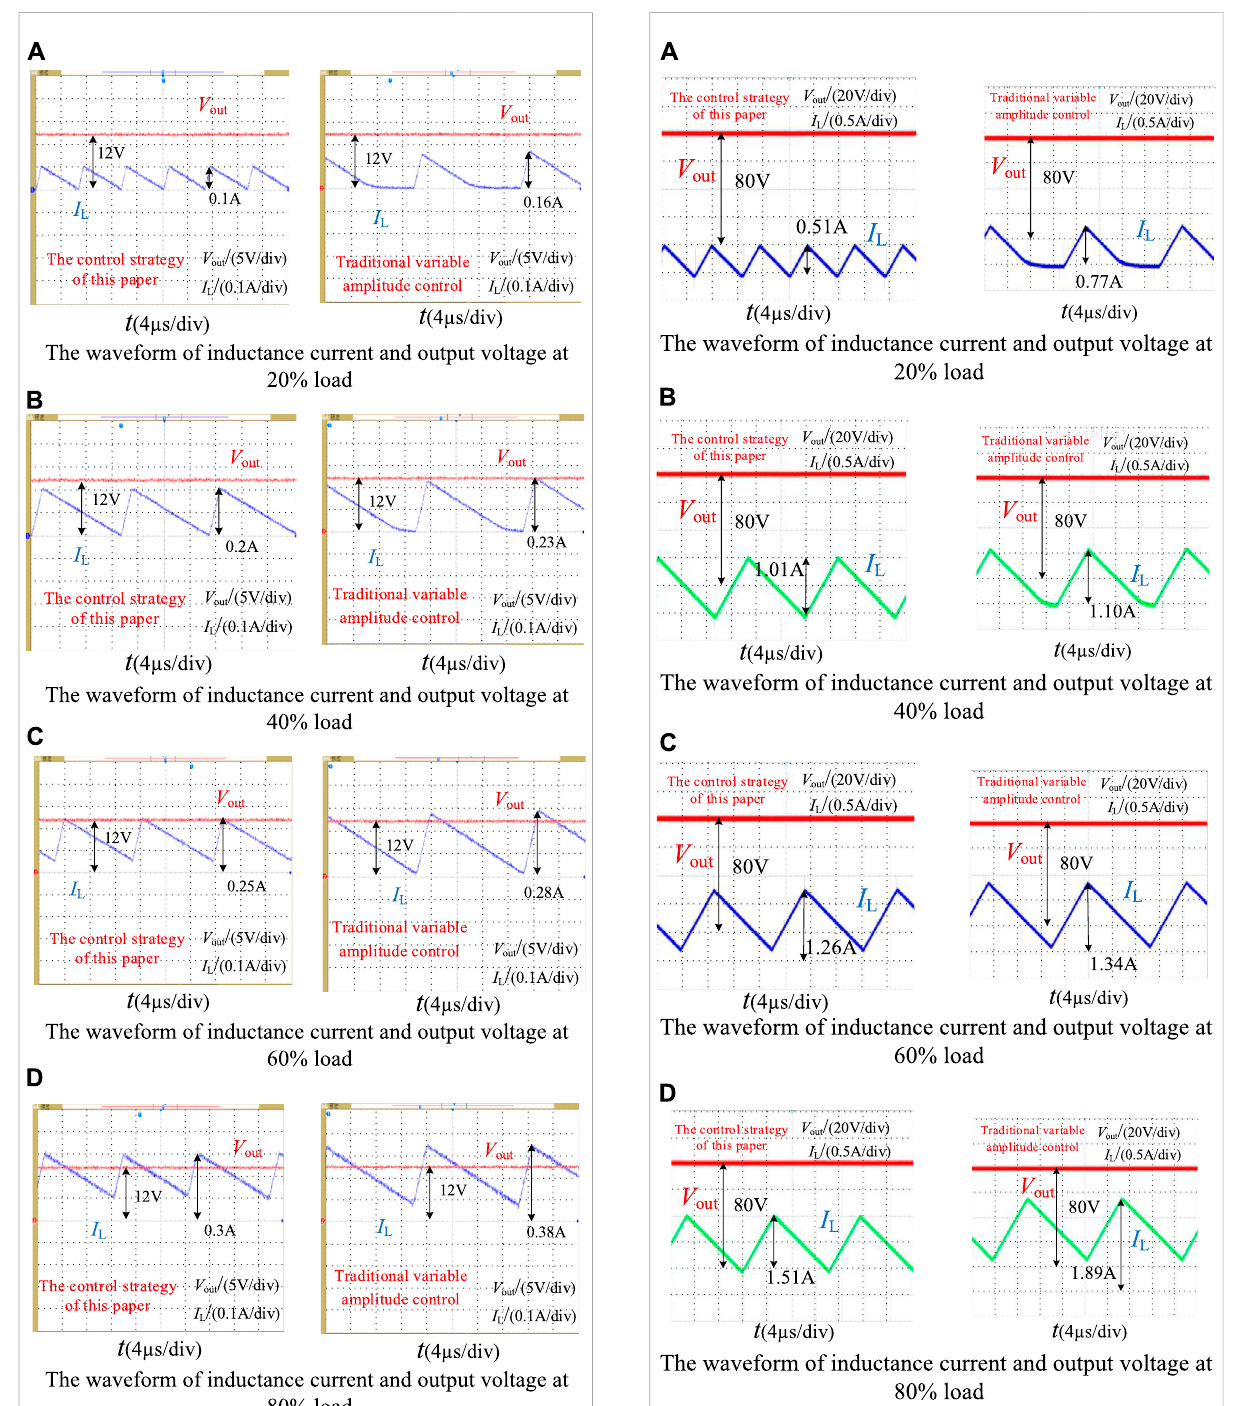
Waveforms under different loads at 3W rated power.